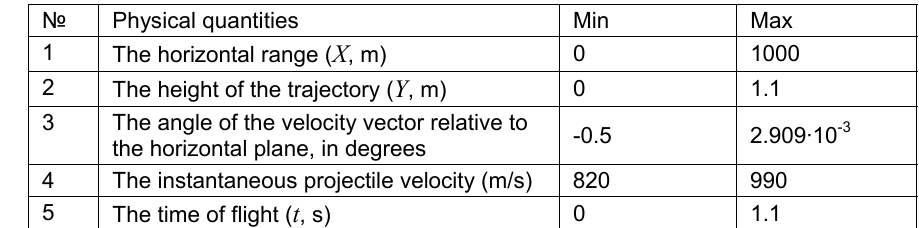
Table 4 – Characterization of the boundaries of